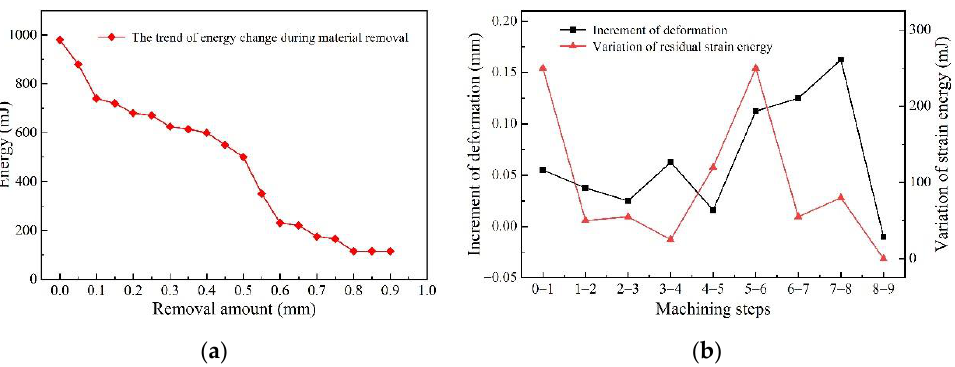
Figure 5. Variation of deformation and strain energy during machining: ( a ) relationship between strain energy and removal amount; ( b ) relationship between the increment of deformation and the variation of residual strain